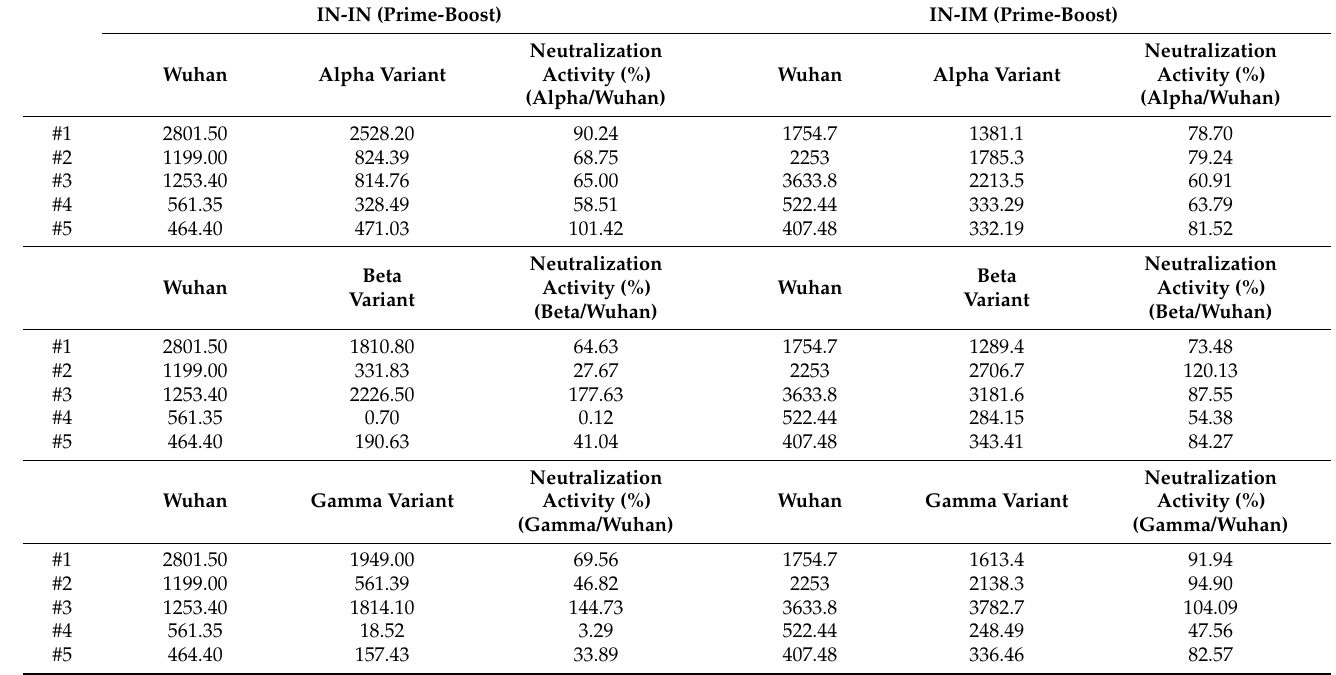
Table 1. Neutralization Titers (IC 50 ) against pseudotyped viruses displaying each spike variant. IN-IN